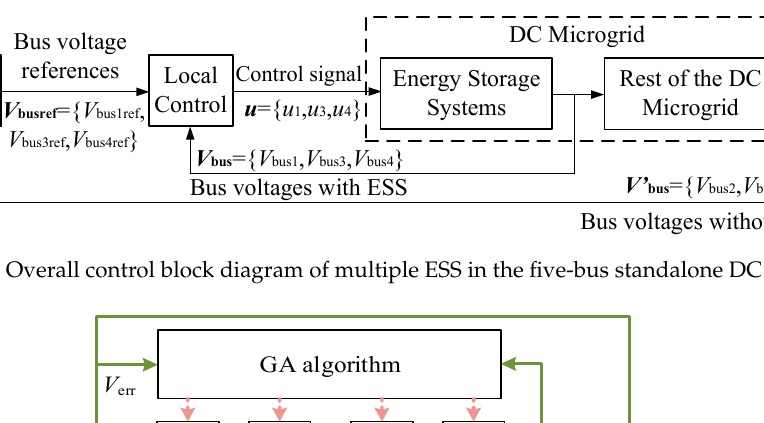
Figure 11. The circuitry and control of the grid-connected converters for energy storage systems (ESS).